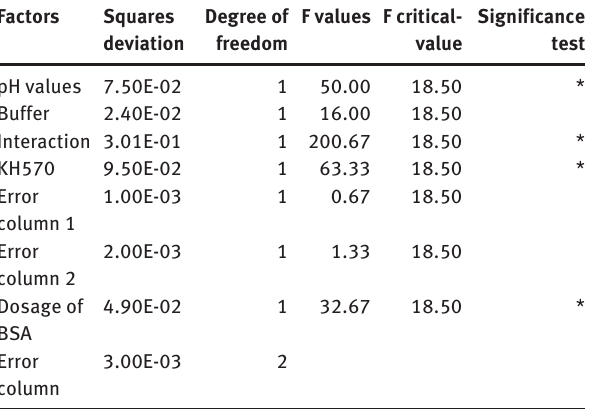
Table 1 Analysis of